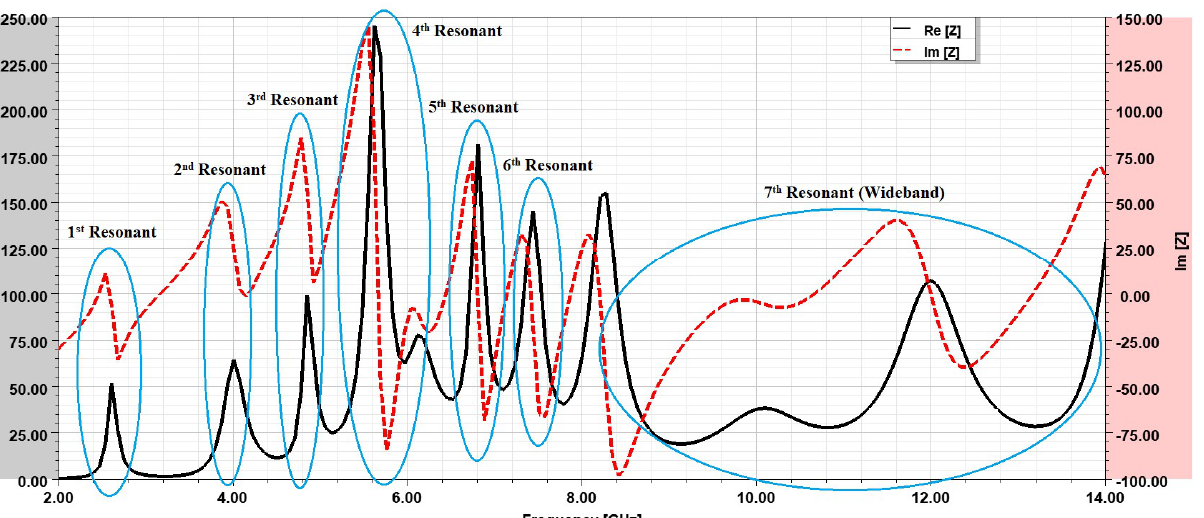
Figure 6. Real and imaginary impedance for the designed model.